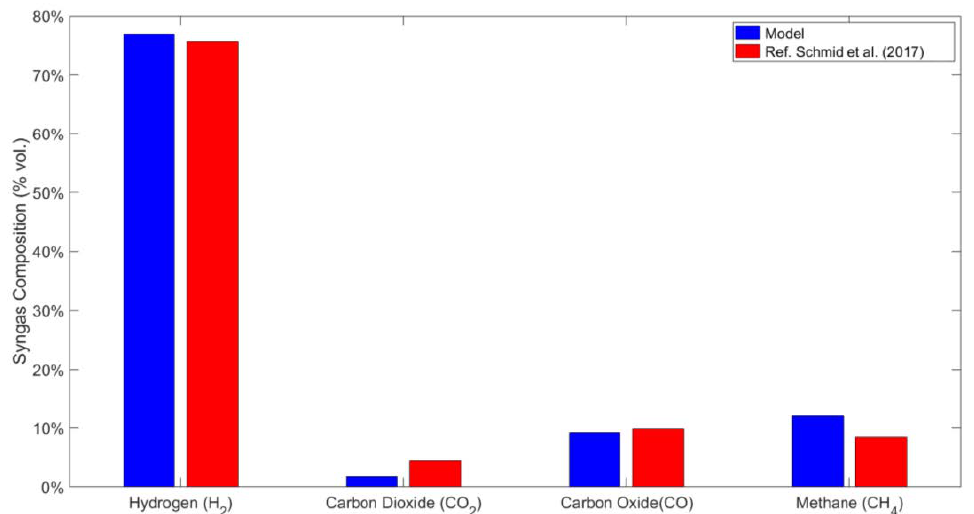
Figure 4. Validation of sorption-enhanced gasification: syngas composition of char gasification at 650 °C, S/B = 1 .